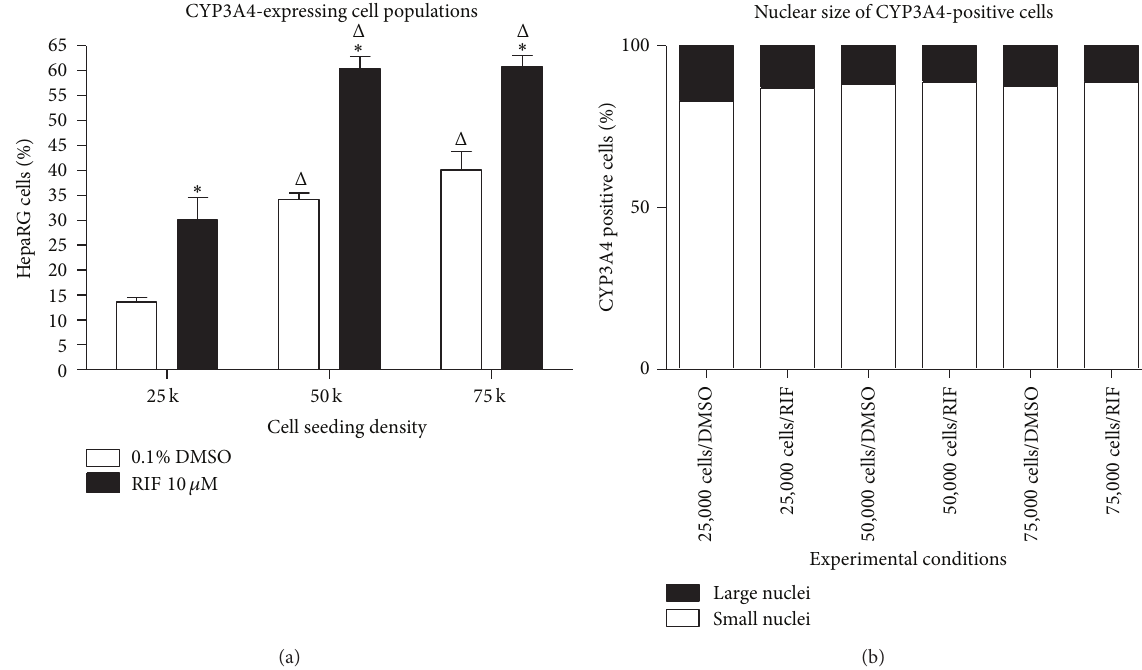
Figure 7: Quantification of numbers of CYP3A4-expressing cells via High Content Analysis. Using quantitative HCA image analysis, the percentage of HepaRG cells staining positively for CYP3A4 in vehicle and 10 𝜇 M rifampicin-treated cells at each cell seeding density was determined.(a)showsthepercentagesofCYP-expressingcellswithintheentireHepaRGpopulationforeachcondition.(b)showsthedivision of CYP3A4-expressing cells by nuclear size; small nuclei = ≤ 125 𝜇 m 2 ; large nuclei = > 125 𝜇 m 2 . Data represent mean ± SEM for 3 independent experiments. ∗ represents 𝑃 < 0.05 versus DMSO vehicle controls at the same cell seeding density; Δ represents 𝑃 < 0.05 versus HepaRG cells seeded at 25,000 cells per